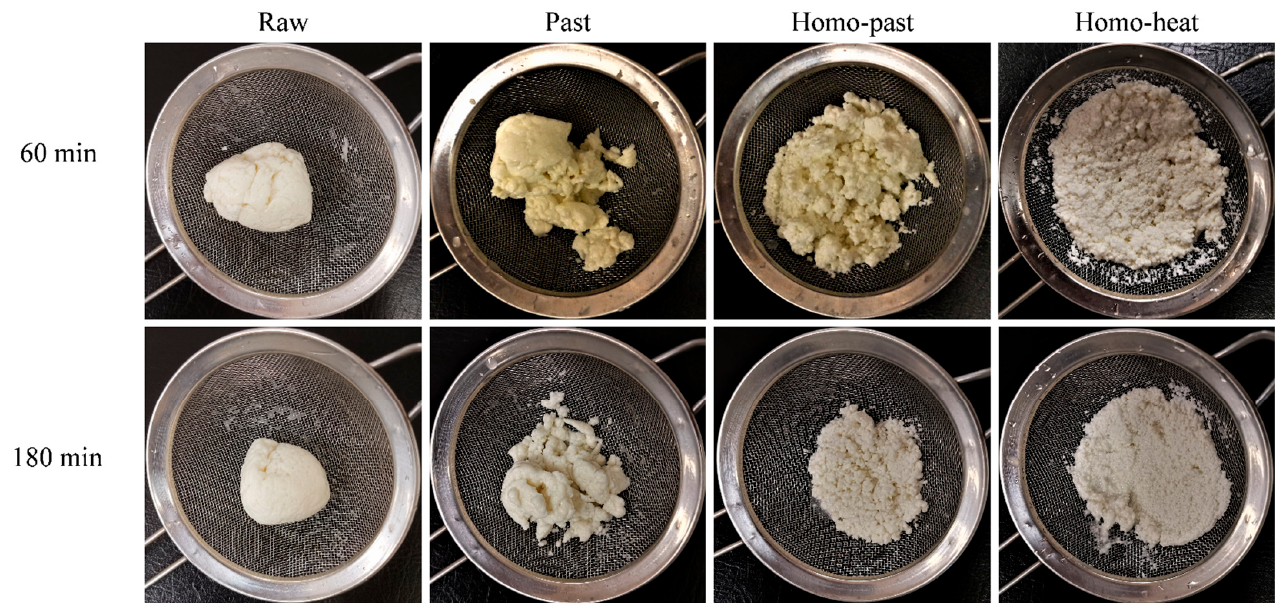
Figure 2 . Appearance of curds collected at 60 and 180 min during the in vitro gastric digestion of raw, pasteurized (Past), homogenized and pasteurized (Homo–past), and homogenized and heated (Homo–heat) sheep milks.